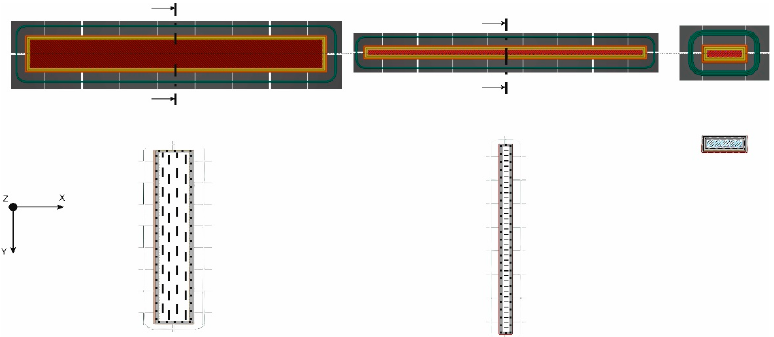
Figure 3. Orientation of fibers inside the tensile samples observed on the cross-section of samples processed according to different orientations, and schematic representation of the expected specimen microstructures [41].